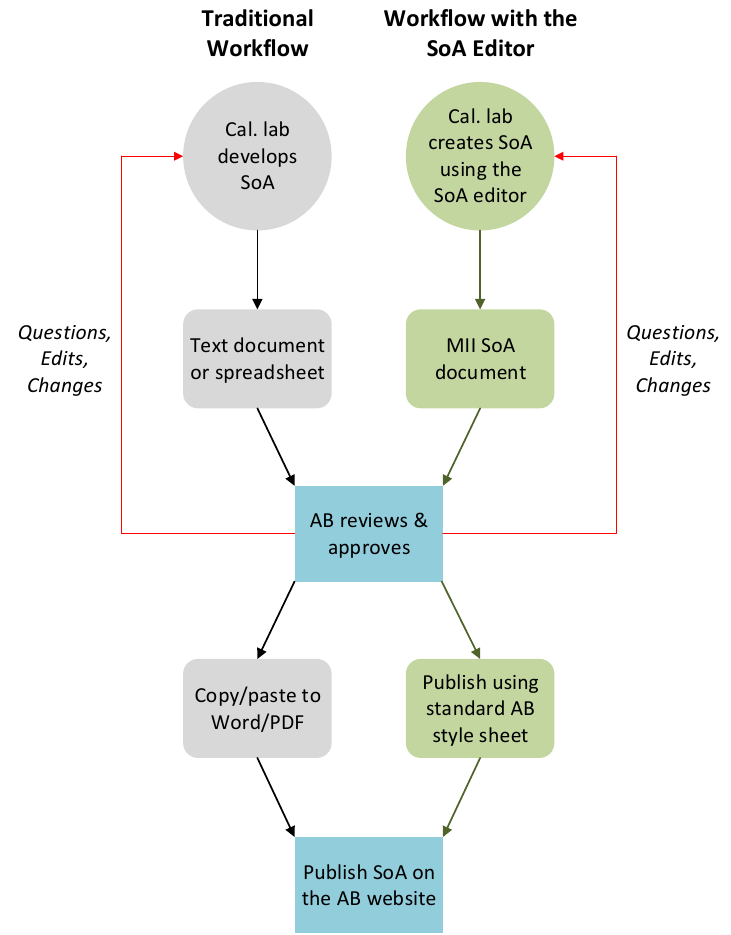
Figure 5. Traditional accreditation workflow vs. workflow with the SoA